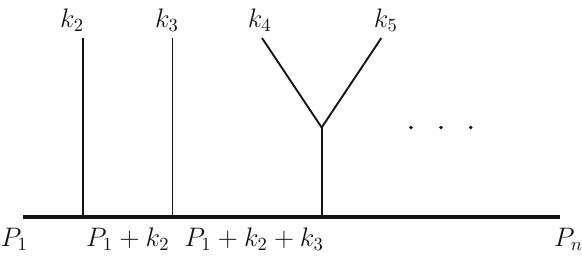
Fig. 3 Diagram for A BAS ( 1 , 2 , 3 , 4 , 5 | 1 , 4 , 2 , 3 , 5 )